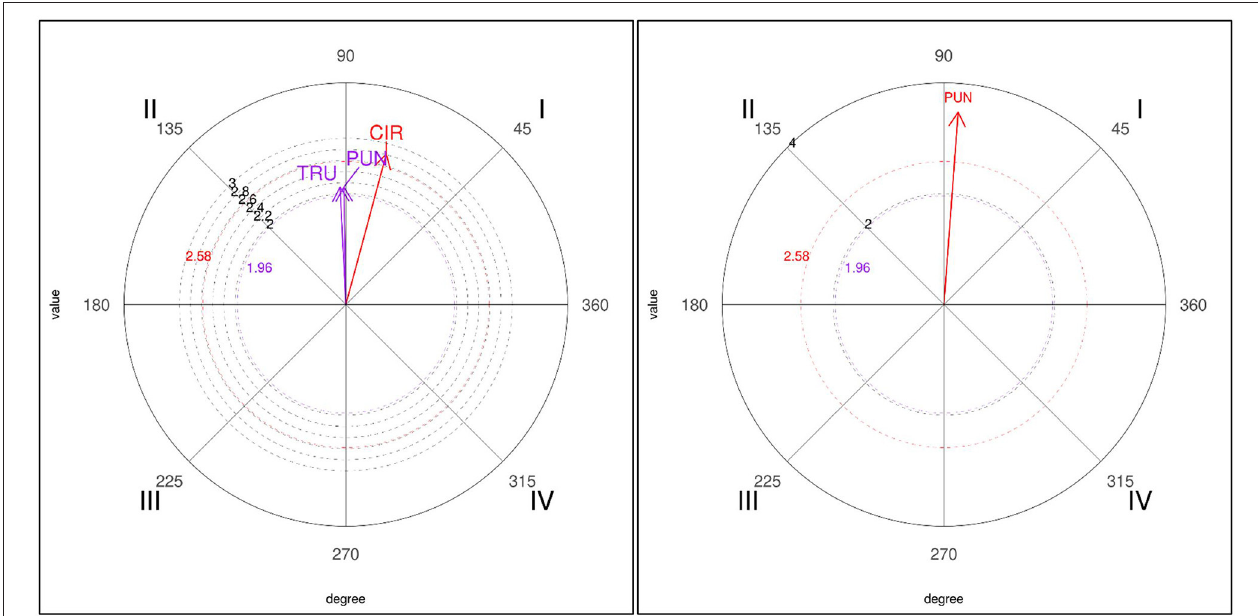
FIGURE 2 | Representation of the behavioral map for the 2P focal behavior in winners (left) and losers (right).